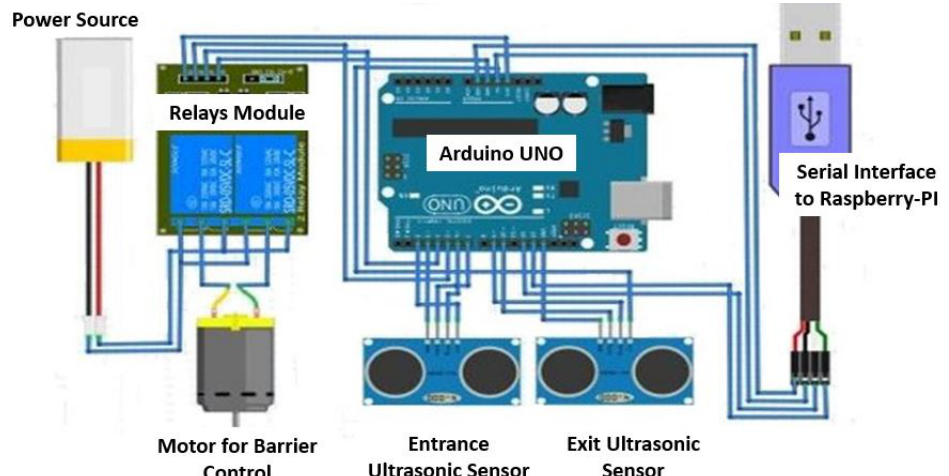
Figure 4. Hardware architecture of an ultrasonic sensors-based vehicle entrance and exit